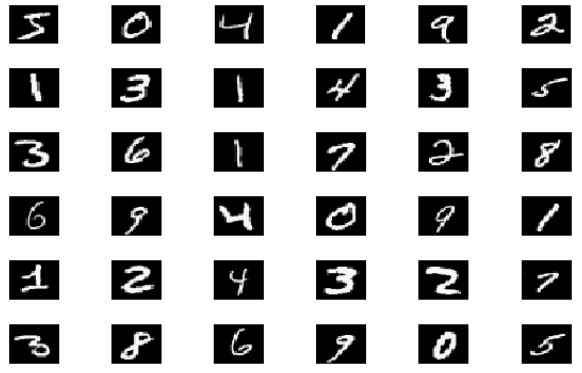
Figure 2. Some examples from the MNIST datasets of handwritten digits.